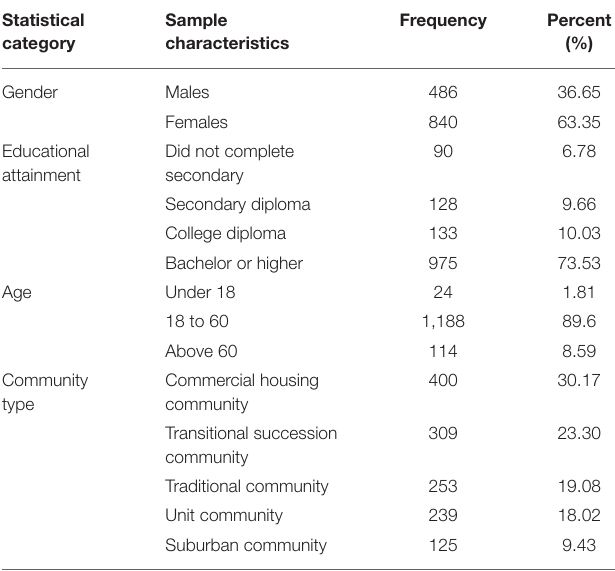
TABLE 1 | Descriptive characteristics of the